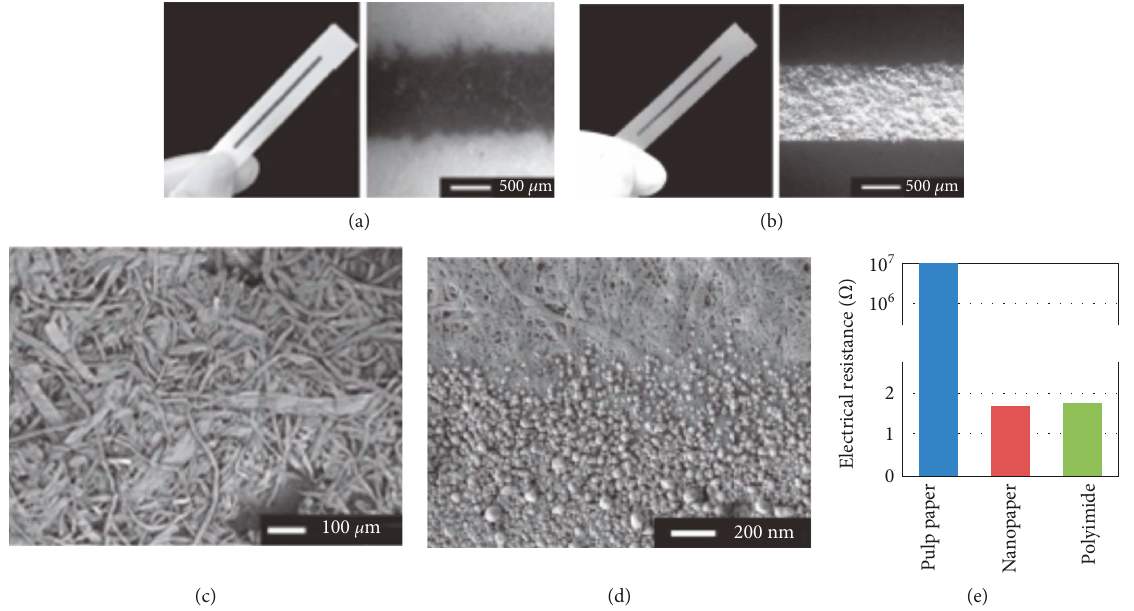
Figure 4: Lines of silver nanoparticles printed on (a) pulp paper and (b) nanopaper. (c, d) SEM micrographs of the printed lines/substrates, with scale bars of 100 μ m for pulp paper and 200 nm for nanopaper. (e) Electrical resistance in ohm of the silver nanoparticle lines deposited on pulp paper (blue), nanopaper (red), and control sample on polyimide (green). Reproduced from reference [28] with permission from the Royal Society of